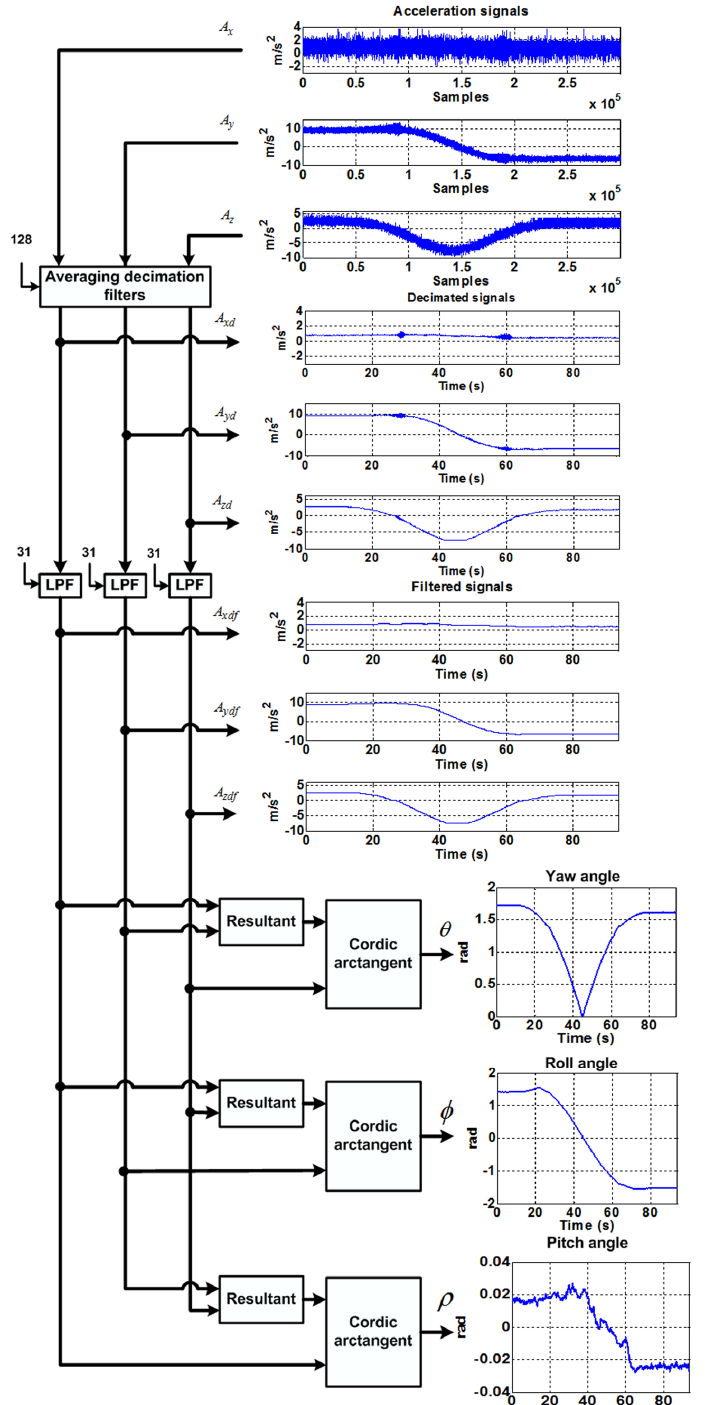
Figure 6. Methodology to estimate inclination angles from accelerometer